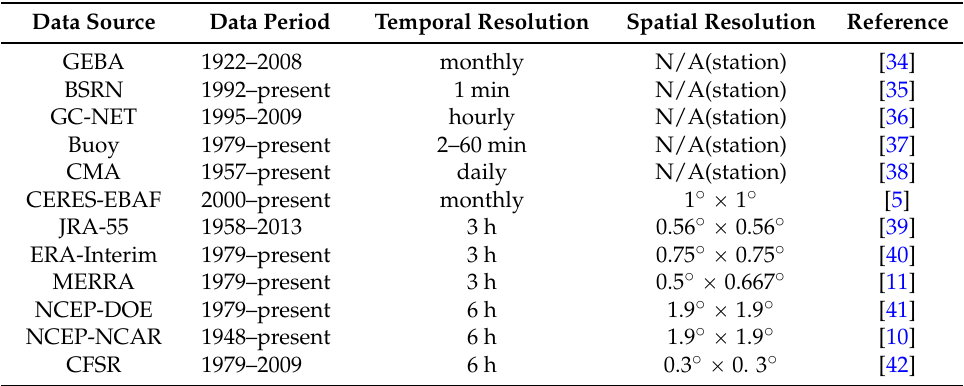
Table 1. Details of the data products used in this